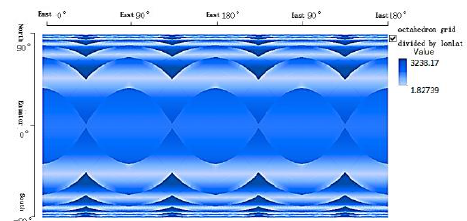
Figure 14. The planar distribution of mean square deviation of major-minor of octahedron grid divided by mixed method